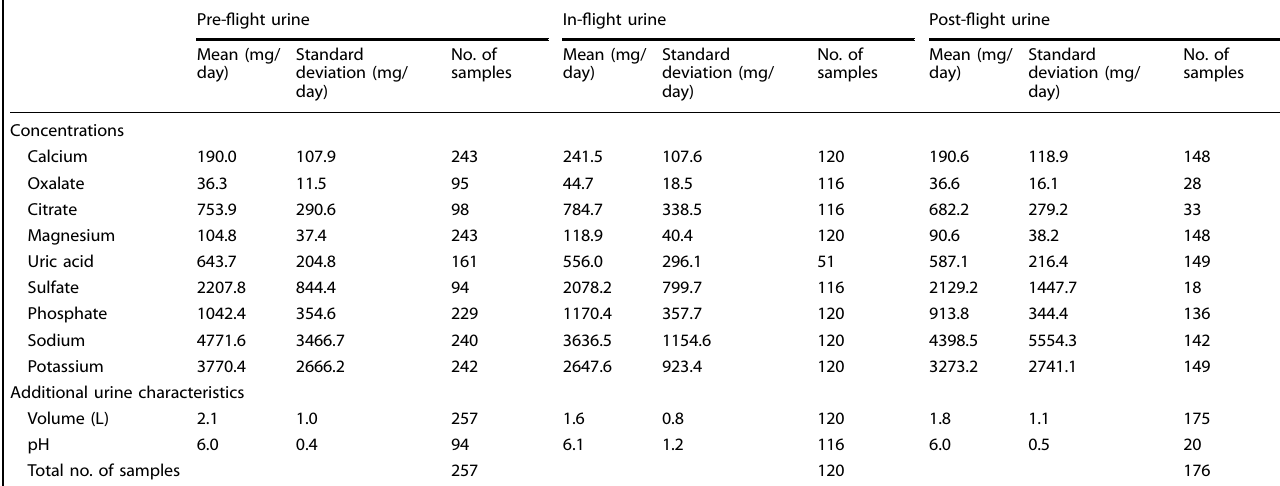
Table 3. The mean, number of samples per measurement, and standard deviation of urine measurements used for testing the model. Pre- fl ight